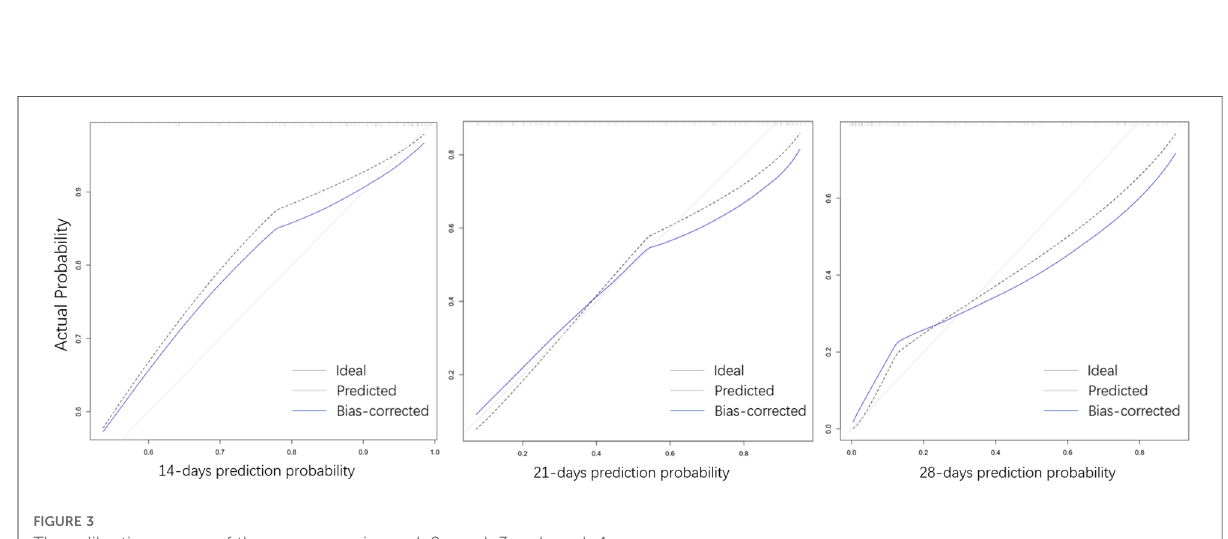
FIGURE 3 The calibration curves of the nomogram in week 2, week 3 and week 4.